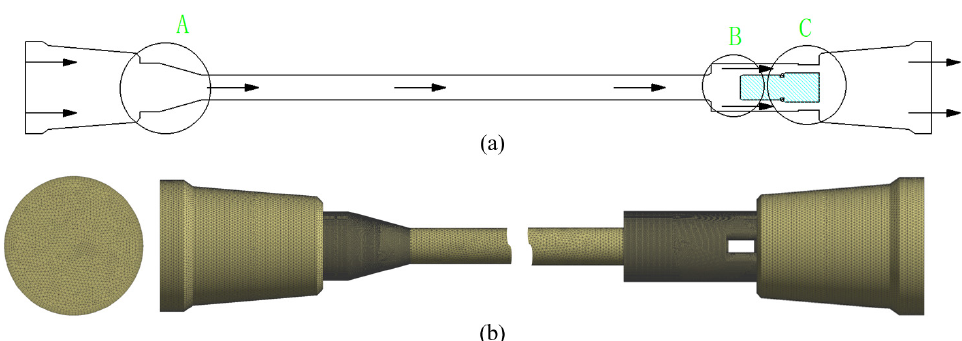
Figure 3. Flow field meshing: ( a ) the simplified flow field geometric diagram, ( b ) the result of meshing the flow field.